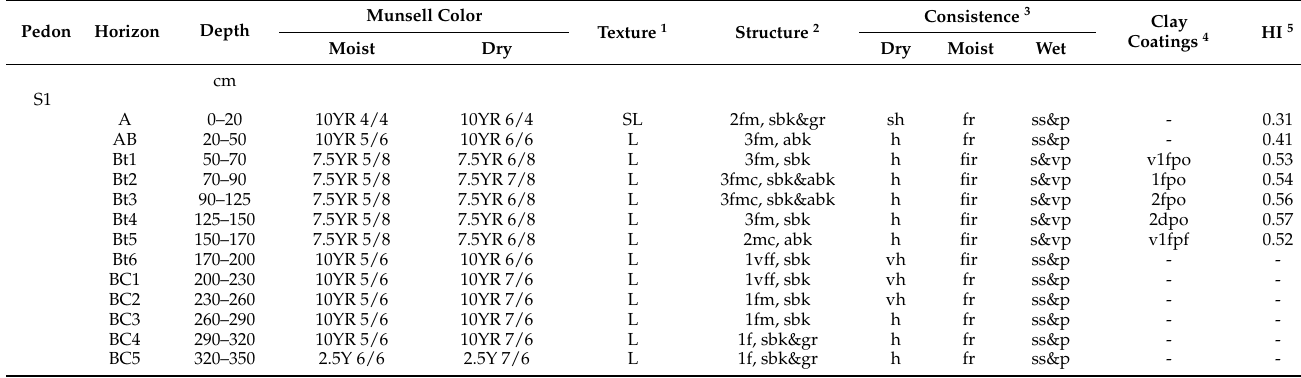
Table 3. Morphologies of the